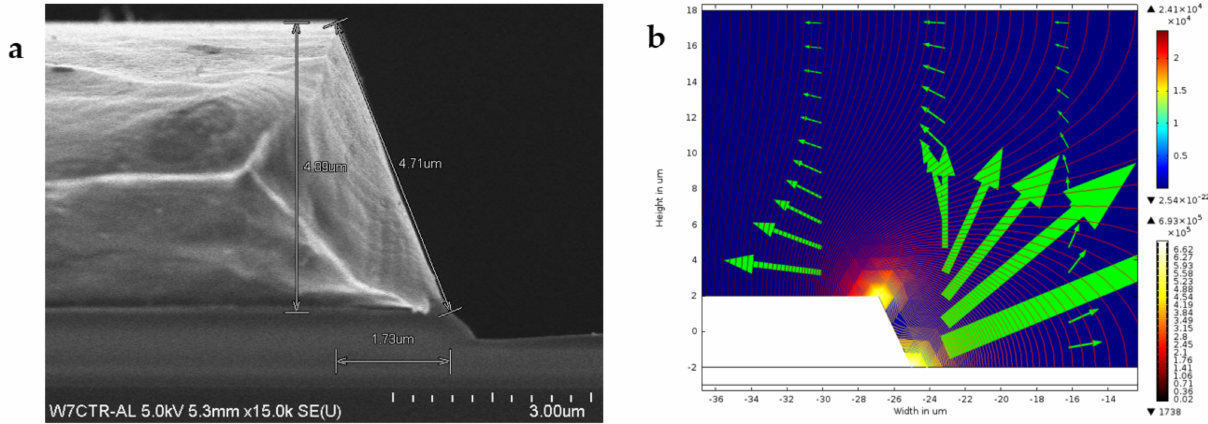
Figure 5. The SEM image of the fabricated microelectrode session of TAMA with measurements is clearly shown in subfigure ( a ). Subfigure ( b ) shows the finite-element method simulation analysis through COMSOL software in which TAMA with a side wall profile of 65 degrees generated the best two spots of high electric field intensity, which subsequently produce lateral and vertical dielectrophoretic forces for particles manipulation. Images are adapted with permission from Buyong et al.